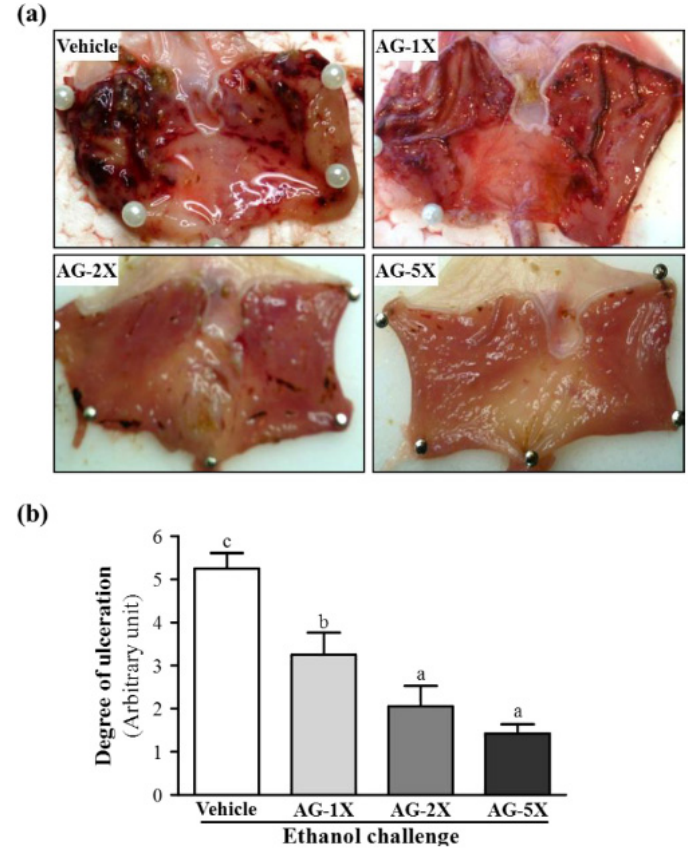
Figure 2. Gross evaluation of rat stomachs with AG treatment. ( a ) Gastric mucosa with pre-treatment with water (vehicle), low-dose (AG-1X), medium-dose (AG-2X) and high- dose (AG-5X) AG at 0, 250, 500 and 1250 mg/kg, respectively, for 4 weeks. At day 29, 75% ethanol was given orally to each animal at 10 mL/kg to induce gastric ulceration for 2 h; and ( b ) The degree of ulceration was expressed by a lesion score of 0 to 6. Data are mean ± SEM. Different letters (a, b, c) indicate significant difference at p <